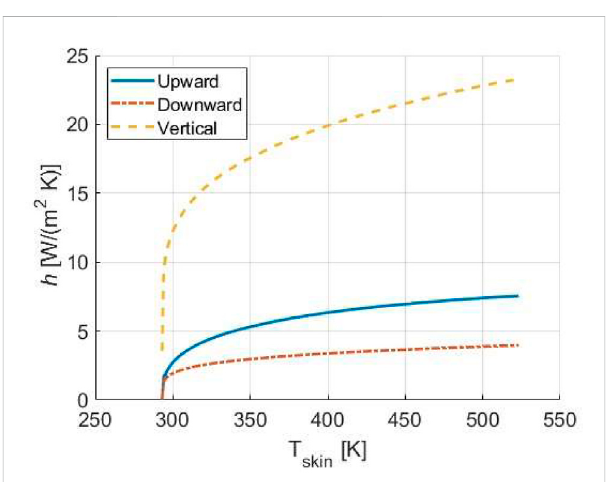
FIGURE 6 Modelof1/4thofthegeometry.Onthesymmetryplaneaperfect magnetic conductor boundary condition is applied. On the anti- symmetry plane a perfect magnetic insulator boundary condition is applied.At thetworemainingedgesoftheplateavolume ofairis modelled. Which corresponds to the assumption that the magnetic fi eld normal to the symmetry plane equals zero and the current cannot have a tangential component.